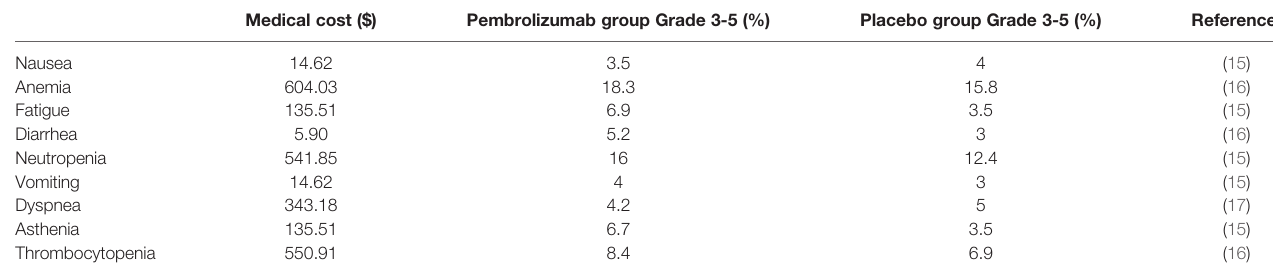
TABLE 2 | Adverse events and costs in the pembrolizumab group and chemotherapy group. Medical cost